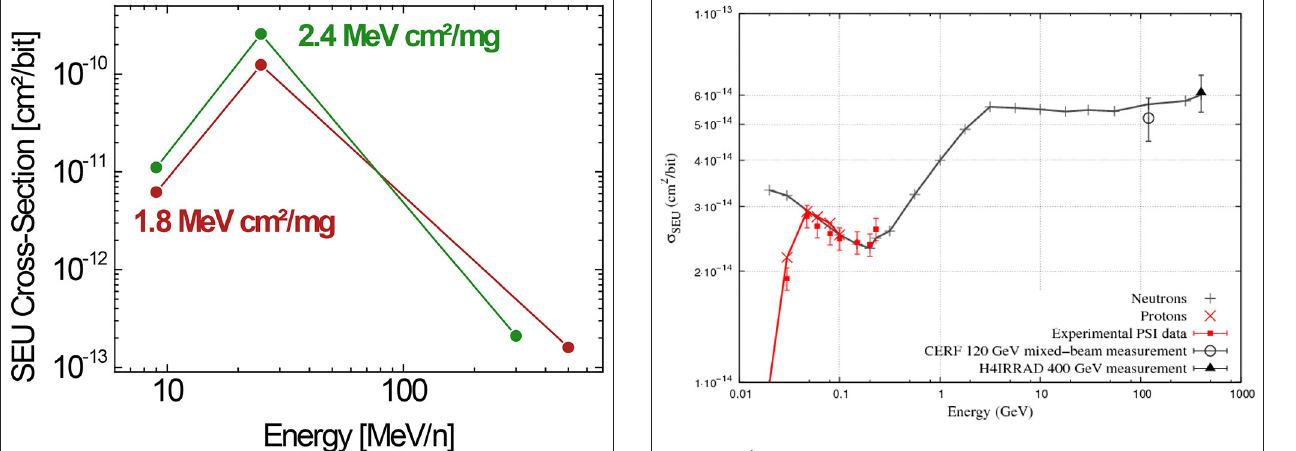
FIGURE 6 | Simulated proton and neutron SEU cross section of the ESA SEU Monitor compared to experimental proton measurements at PSI